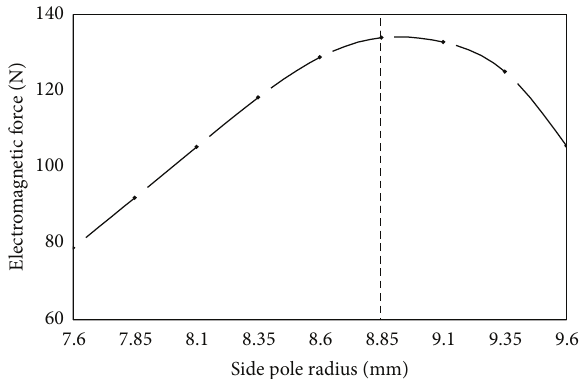
Figure 12: Influence of coil location on electromagnetic